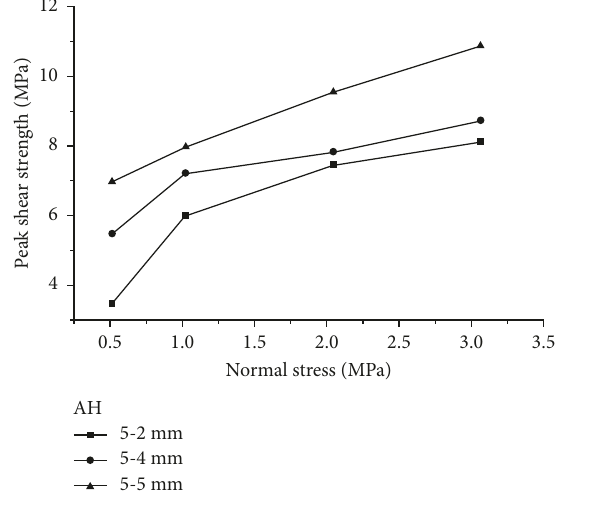
Figure 19: The τ - σ curve of the quasi-3D discontinuity under different asperity heights.